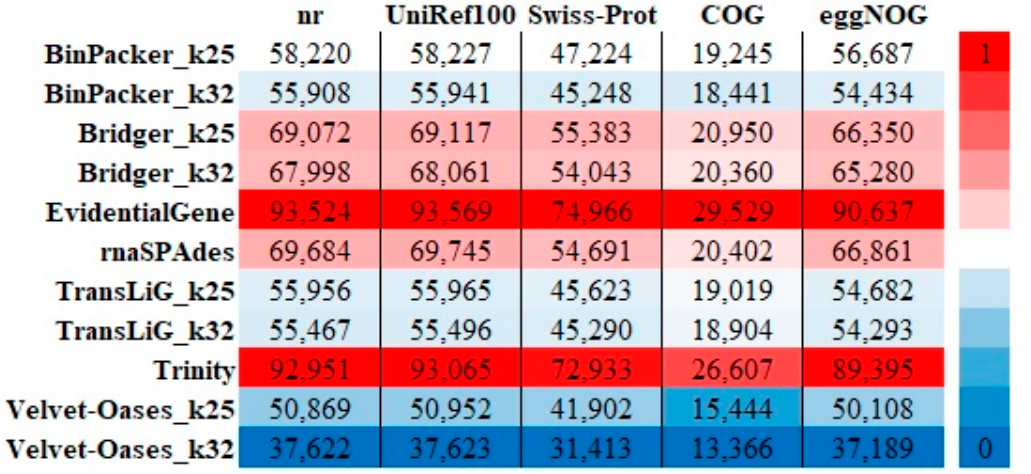
Figure 6. Unique hits in BLASTx (e-value cutoff ≤ 1 × 10 − 5 ) searches of 11 transcriptomes against five major databases: NR, UniRef100, Swiss-Prot, COG, and